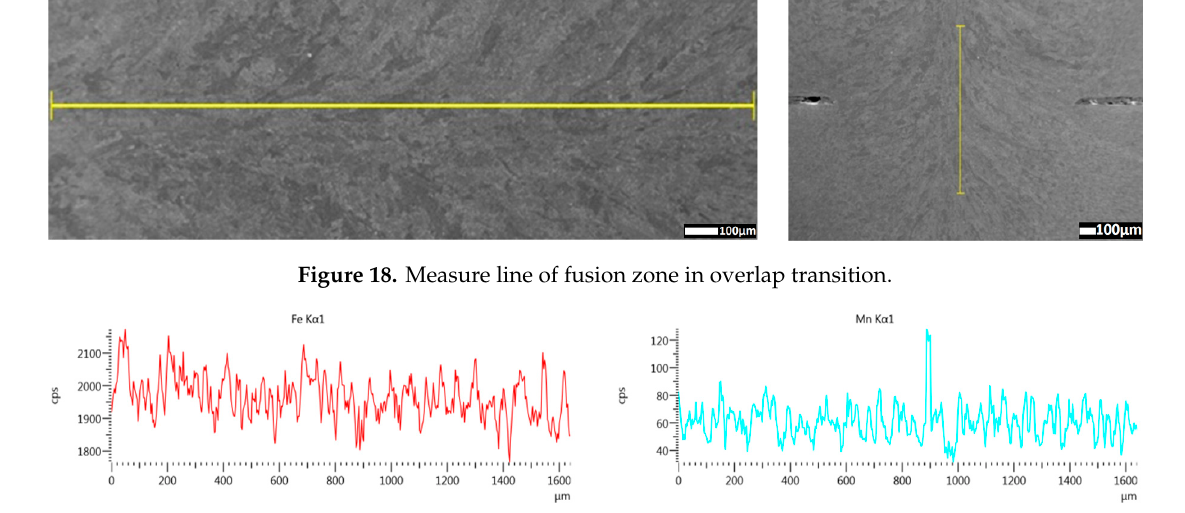
Figure 19. Ferrite and manganese amount along the overlap transition measurement line.